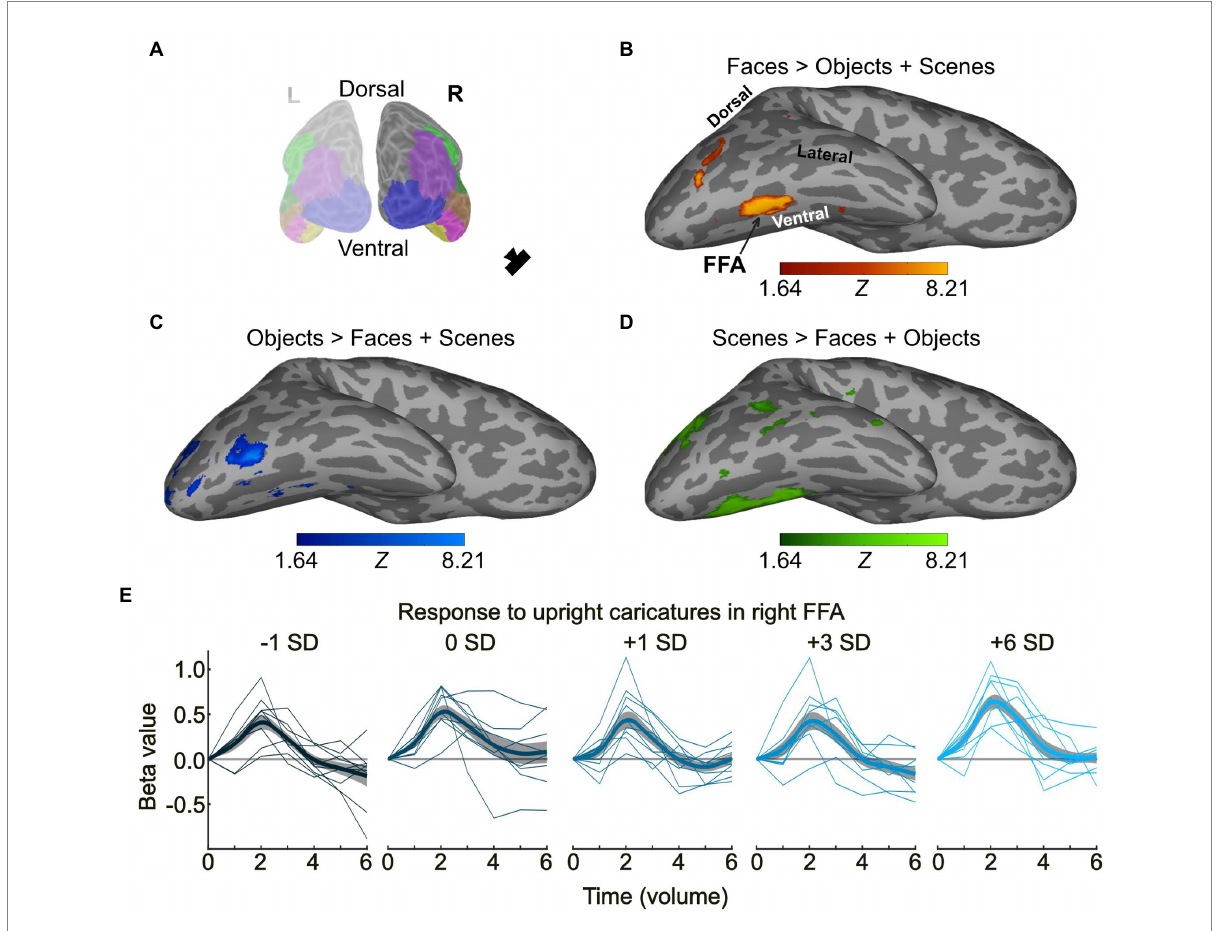
FIGURE 3 Defining face, object, and scene-selective regions and event-related fMRI responses in right FFA. (A) Posterior view of left and right inflated cortical hemispheres. Camera symbol indicates the view in panels B-D. Light grey, gyri; dark grey sulci. Regions in colour, Freesurfer parcellations used to form the bilateral occipitotemporal ROI, including lateral occipital (blue), fusiform gyrus (yellow), inferior temporal (pink), middle temporal (brown), bank of the superior temporal sulcus (dark green), inferior parietal (purple) and supramarginal gyrus (light green). (B) Face-selective regions in one participant based on the contrast faces > objects + scenes from the localiser scans (FFA, fusiform face area). Object-selective (C) and scene- selective (D) voxels defined using the contrasts objects > faces + scenes, and scenes > faces + objects, respectively. The colour bars in B-D show the Z-statistic for the contrast, thresholded at Z > 1.64 (corresponding to p < 0.05, with FWE correction). Maps show the voxels exclusively defined by these contrasts, with any overlap removed. (E) Response amplitude in the right FFA across participants from stimulus onset as a function of time for the five different levels of caricaturing (upright only) from the deconvolution analysis. Y values show the beta-coefficients from the deconvolution, normalised to t = 0. Thin lines show the average timeseries for each participant. Thick lines show the group average, smoothed over time (for display purposes only). Shaded areas show ± 1 SEM across participants. Solid grey line shows Y = 0. Colour represents the caricature